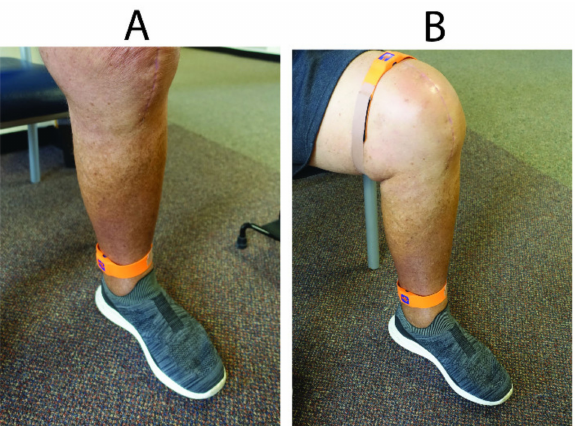
Figure 2. Inertial measurement unit (Vicon Blue Trident sensor) strapped to the ankle of the patient ( A ), as worn during weekly remote home monitoring after outpatient rehabilitation clinics. An additional thigh-worn sensor ( B ) was taped to the distal thigh pre-operatively and at Post-Op Week 6 to determine maximum knee flexion